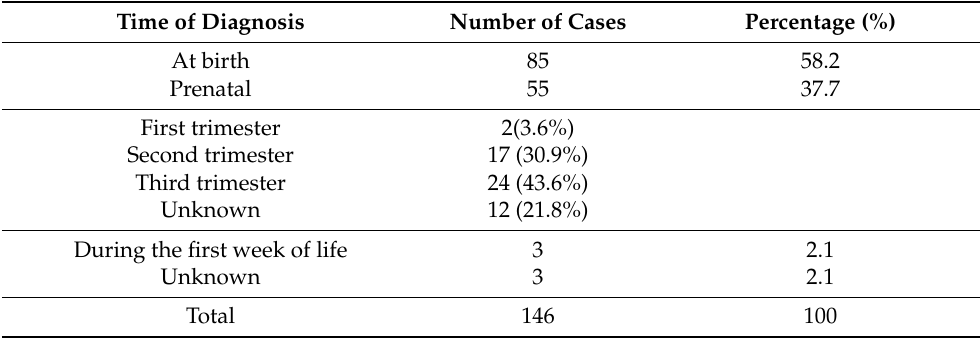
Table 5. Distribution of cases with oesophageal atresia according to the time of diagnosis during the period 2007–2019 in the Valencian Region.